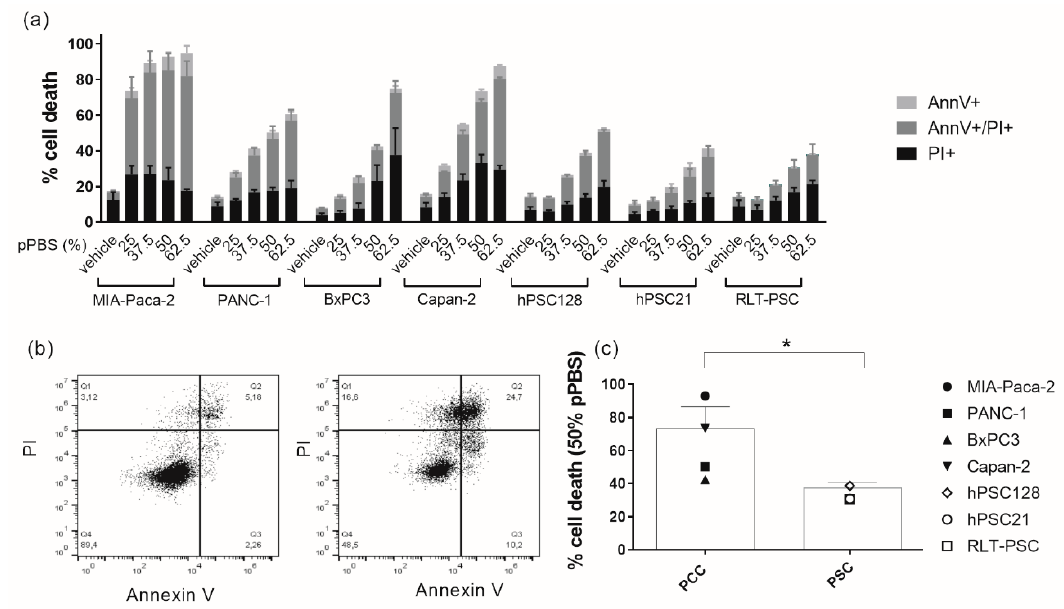
Figure 1. Sensitivity of pancreatic cancer cell (PCC) lines and pancreatic stellate cell (PSC) lines to different doses of plasma-treated phosphate-buffered saline (pPBS) treatment. ( a ) Percentage of cytotoxicity 48 h post pPBS treatment in four different PCC lines (MIA-Paca-2, PANC-1, BxPC3, Capan-2) and three different PSC lines (hPSC128, hPSC21, RLT-PSC). Subdivisions in the percentage Annexin V+, PI+, and double positive cytotoxic cells are made. ( b ) Dot plots showing the flow cytometric analysis of Annexin V and PI staining after 25% pPBS treatment in MIA-Paca-2 (right) compared with the untreated control (left): Q1 = AnnV − /PI+; Q2 = AnnV+/PI+; Q3 = AnnV − /PI − ; Q4 = AnnV+/PI − . Representative dot plots for all other cell lines are presented in Supplemental Figures S1 and S2. ( c ) The difference in sensitivity after 48 h of 50% pPBS treatment for means of all PCC lines and all PSC lines. Graphs represent mean ± SEM of ≥ 3 independent experiments. * p < 0.05.